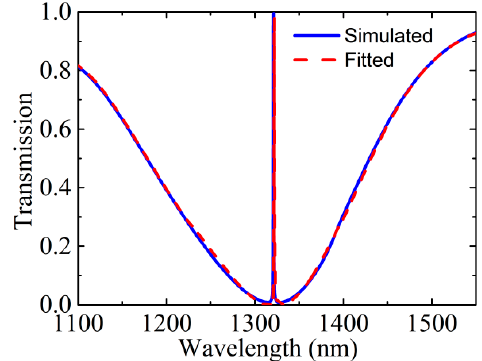
Figure 3. Transmission spectrum of the all-dielectric metasurface without graphene: the blue solid and the red dashed lines represent the simulated and fitted spectra, respectively.